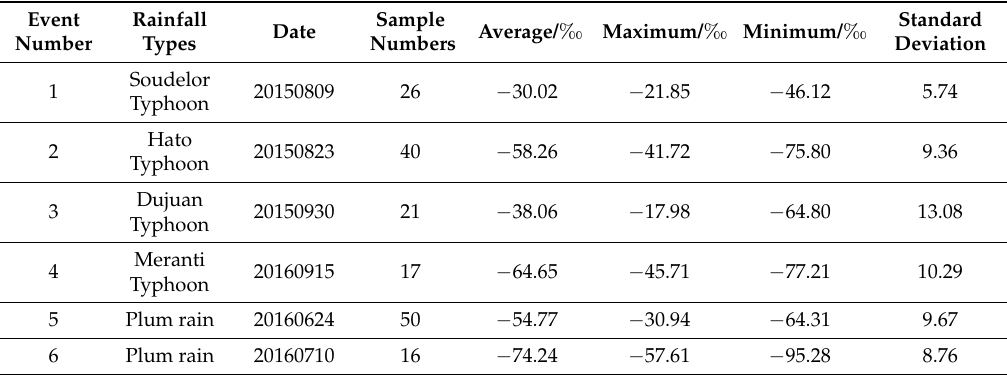
Figure 2. Temporal variation of δ 2 H and δ 18 O in precipitation for six rainfall events. The horizontal ordinate refers to sampler number of sequential rainfall sampler improved from Kennedy. Six figures represent six rainfall events from Event 1 to Event 6, respectively. Table 2. δ 2 H values in precipitation for six selected rainfall